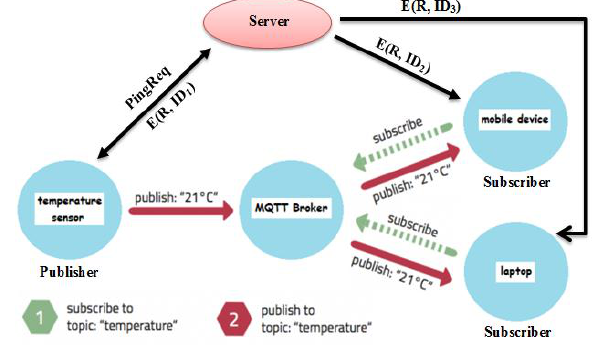
Figure 1. IoT based Home Automation